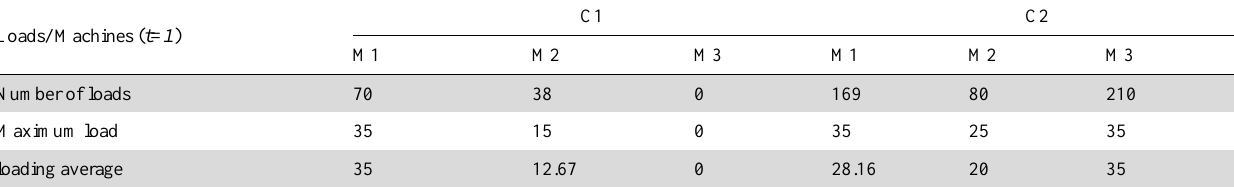
Results of machine loads in first period of final solution of the experiment